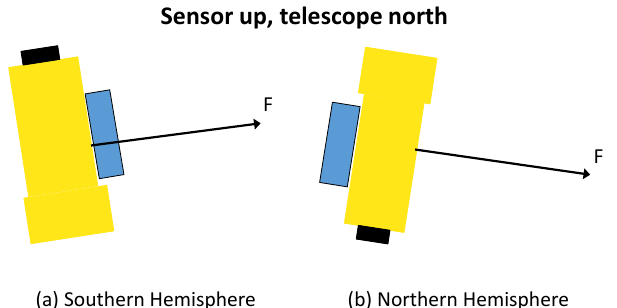
Figure 8. The position “sensor up, telescope north” is shown for a theodolite near the magnetic equator on the Southern Hemisphere (a) and the Northern Hemisphere (b) . Depending on the magnetic hemisphere, these positions differ by 180 ◦